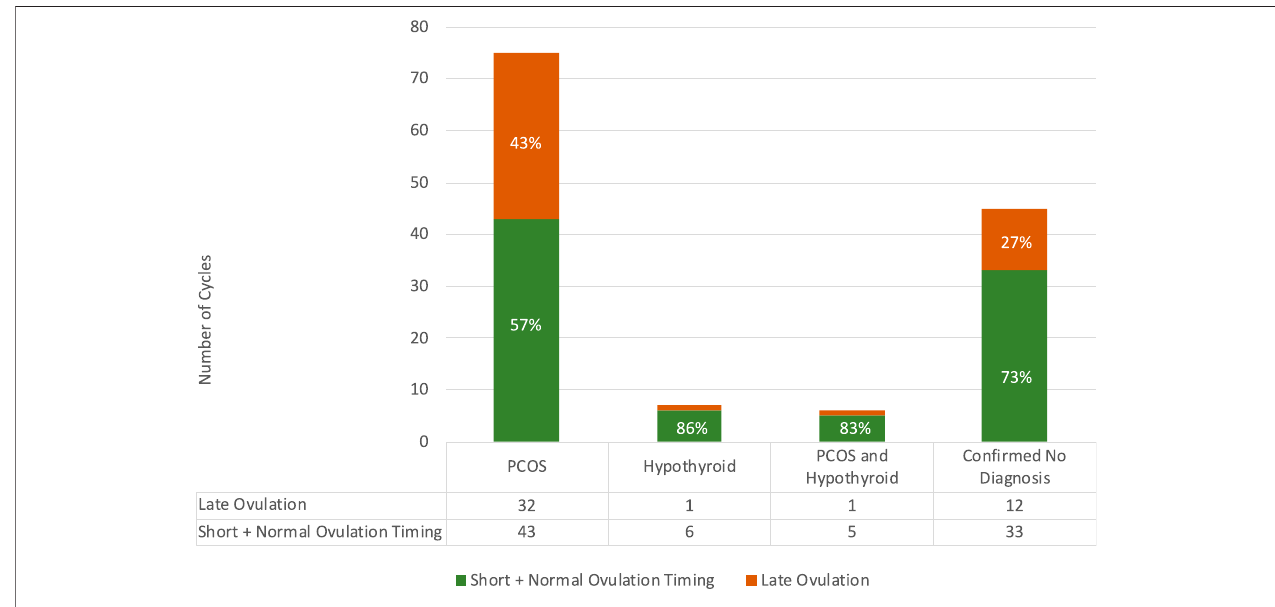
FIGURE 1 | Relationship between ovulation timing and con fi rmed diagnosis in the study population with numbers of cycles per category tabulated.